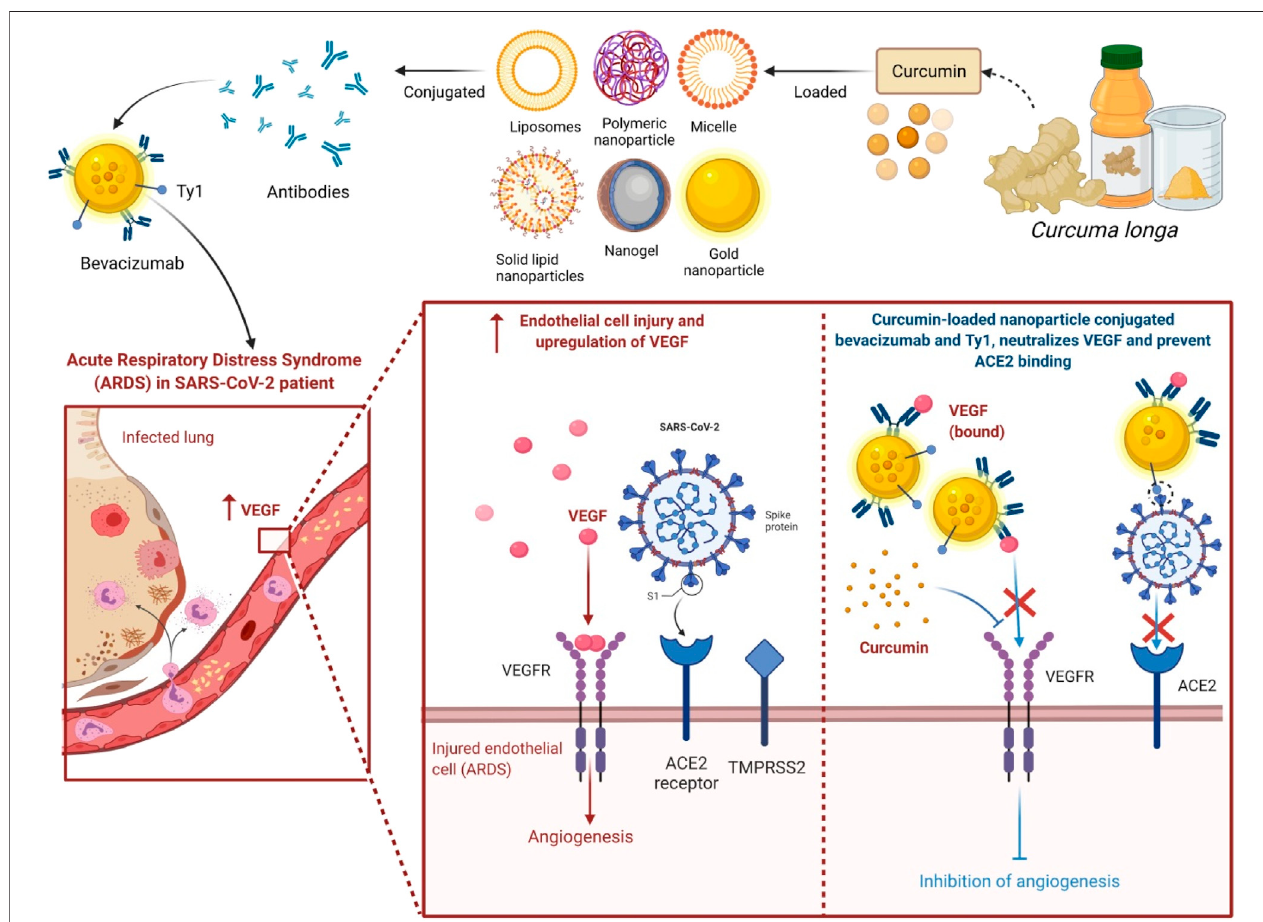
FIGURE 10 | Future perspective of curcumin-loaded gold nanoparticles functionalized with Ty1 and bevacizumab in a patient infected with SARS-CoV-2 (COVID-19).